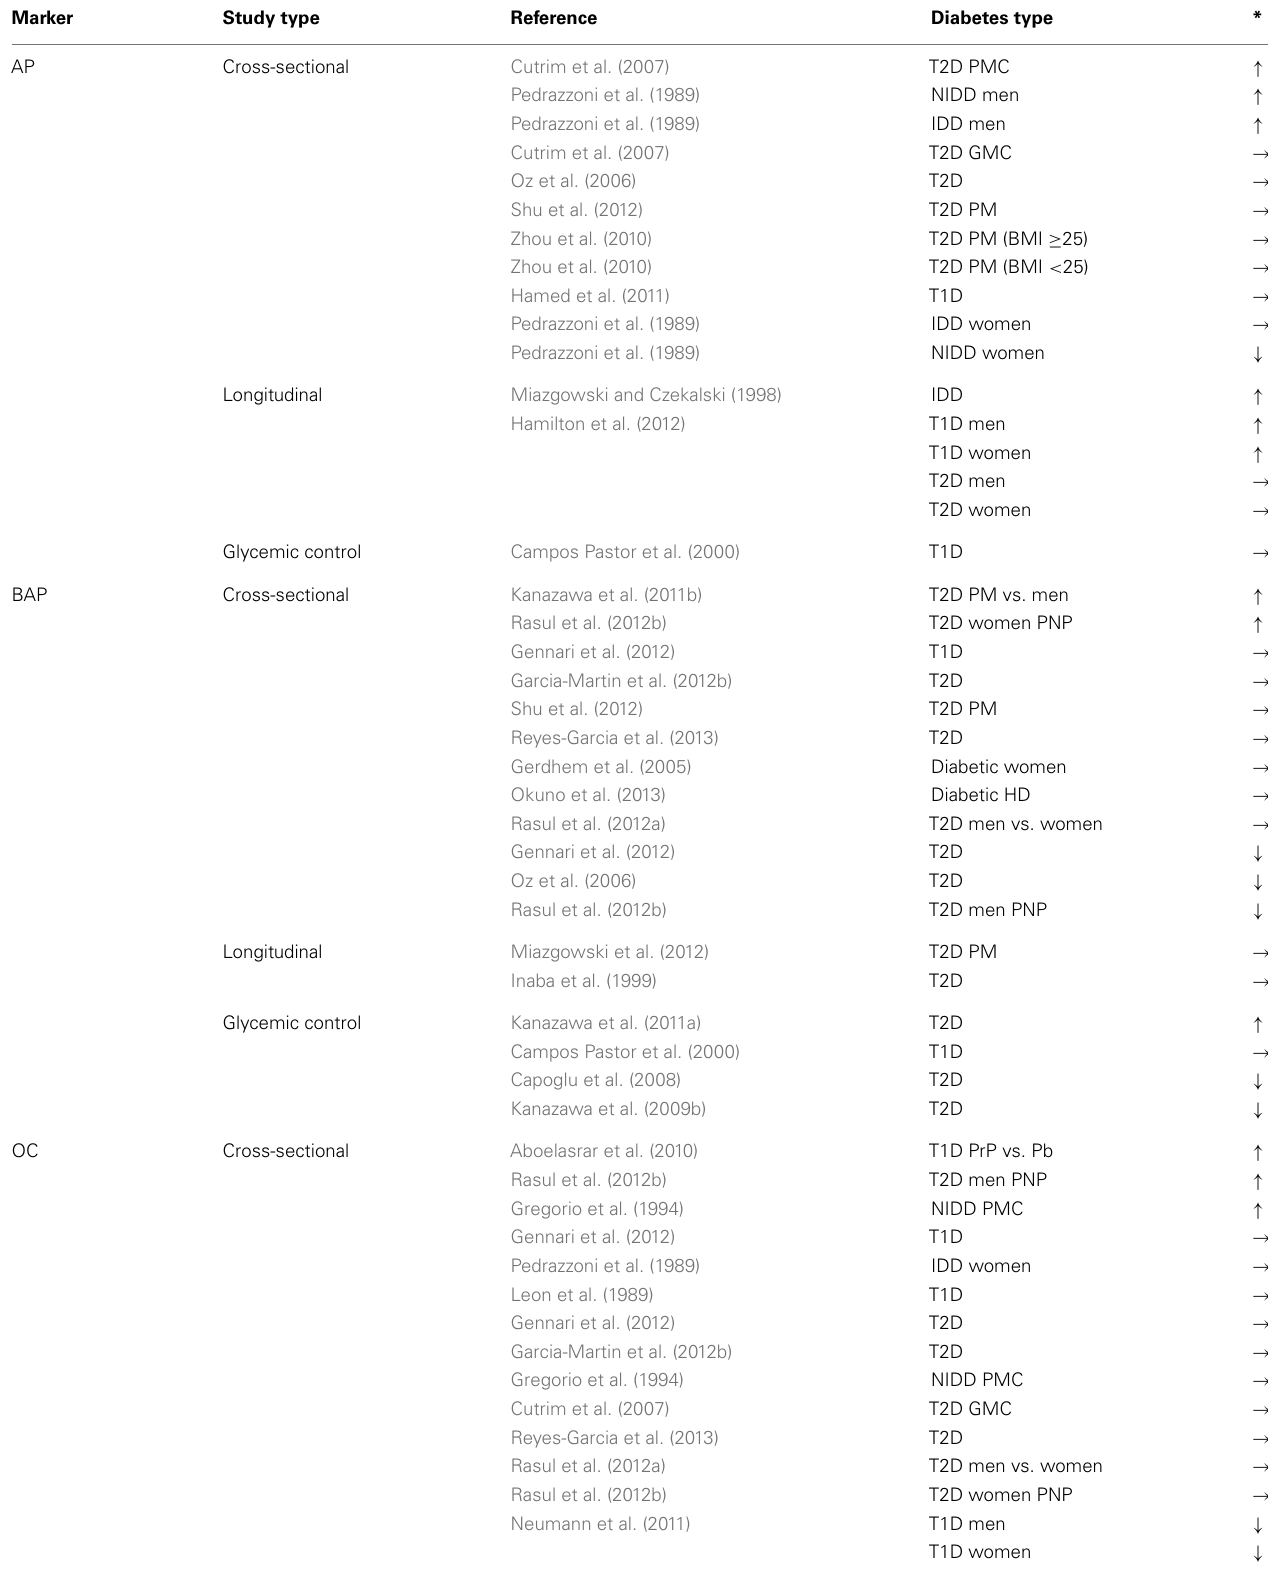
Table 2 | Bone formation